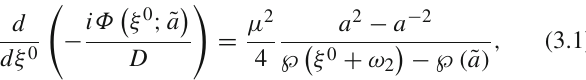
solutionsofthesine-Gordonequation,onewithanoscillatory seed and one with a rotating